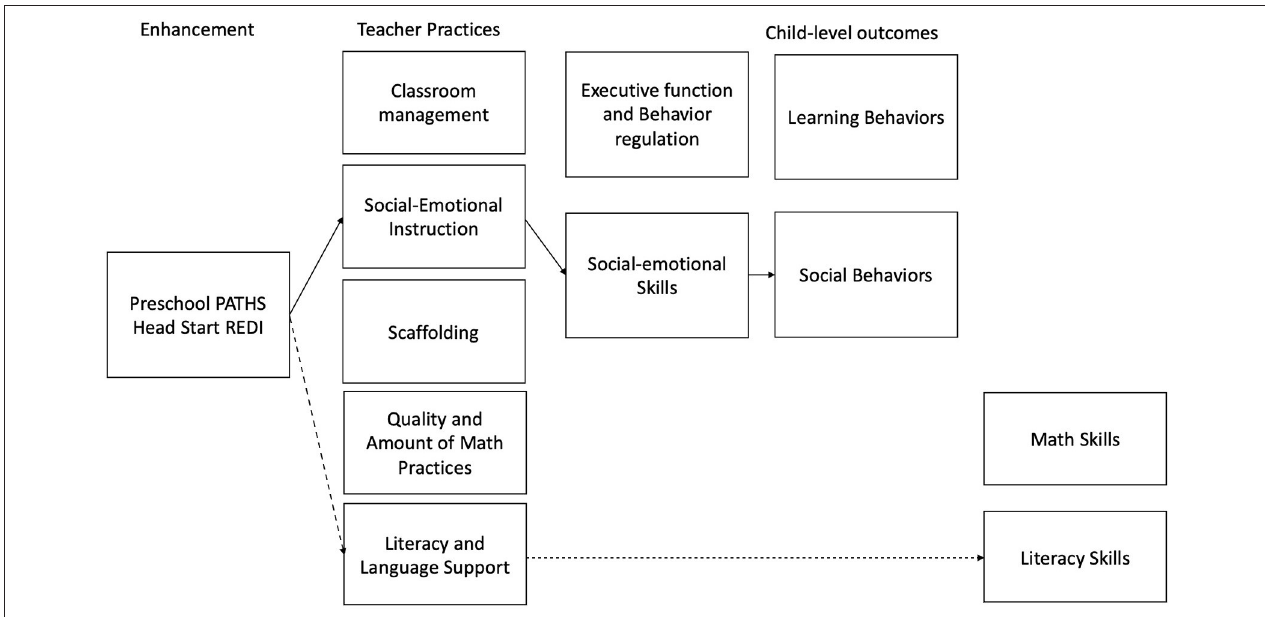
FIGURE 2 | Hypothesized theory of change for social-emotional learning